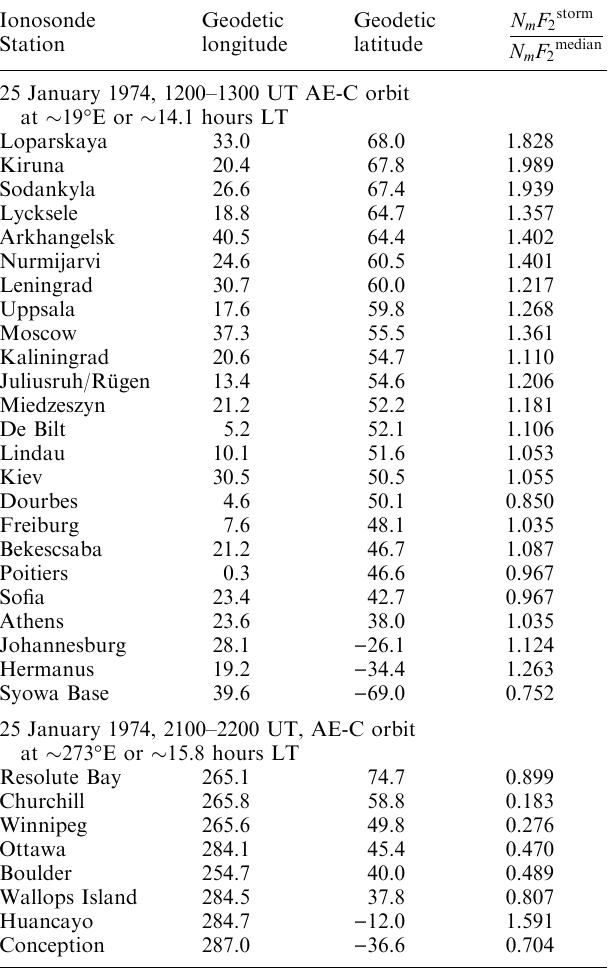
Table 1. Ionosonde observations near AE-C overflights at 1250 UT and 2133 UT respectively Ionosonde Station